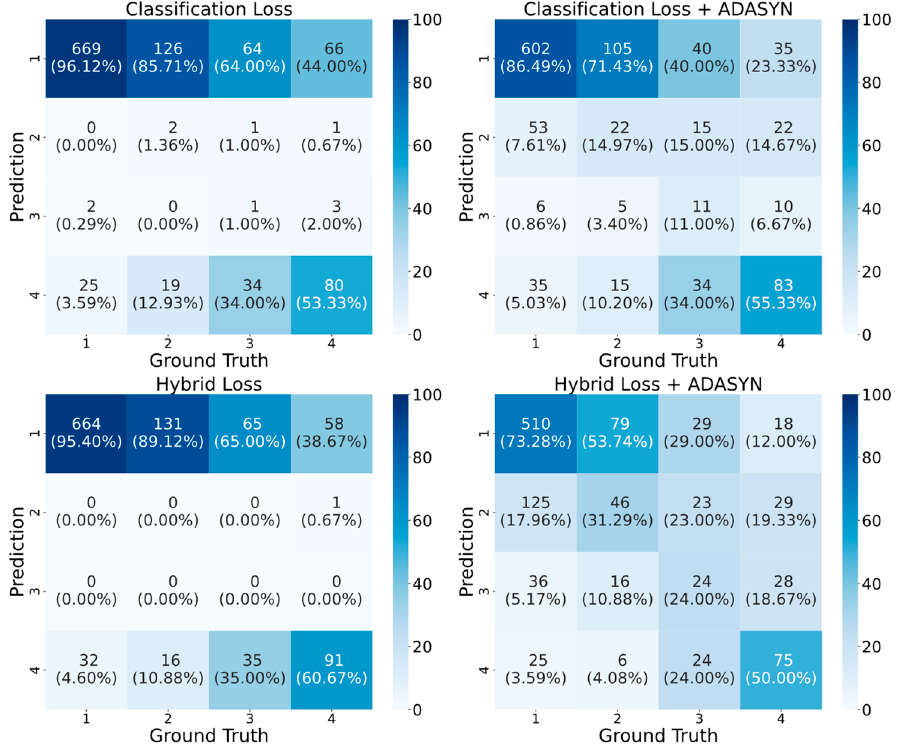
Figure 7. Confusion matrices of RRI models based on the methods in the test dataset.